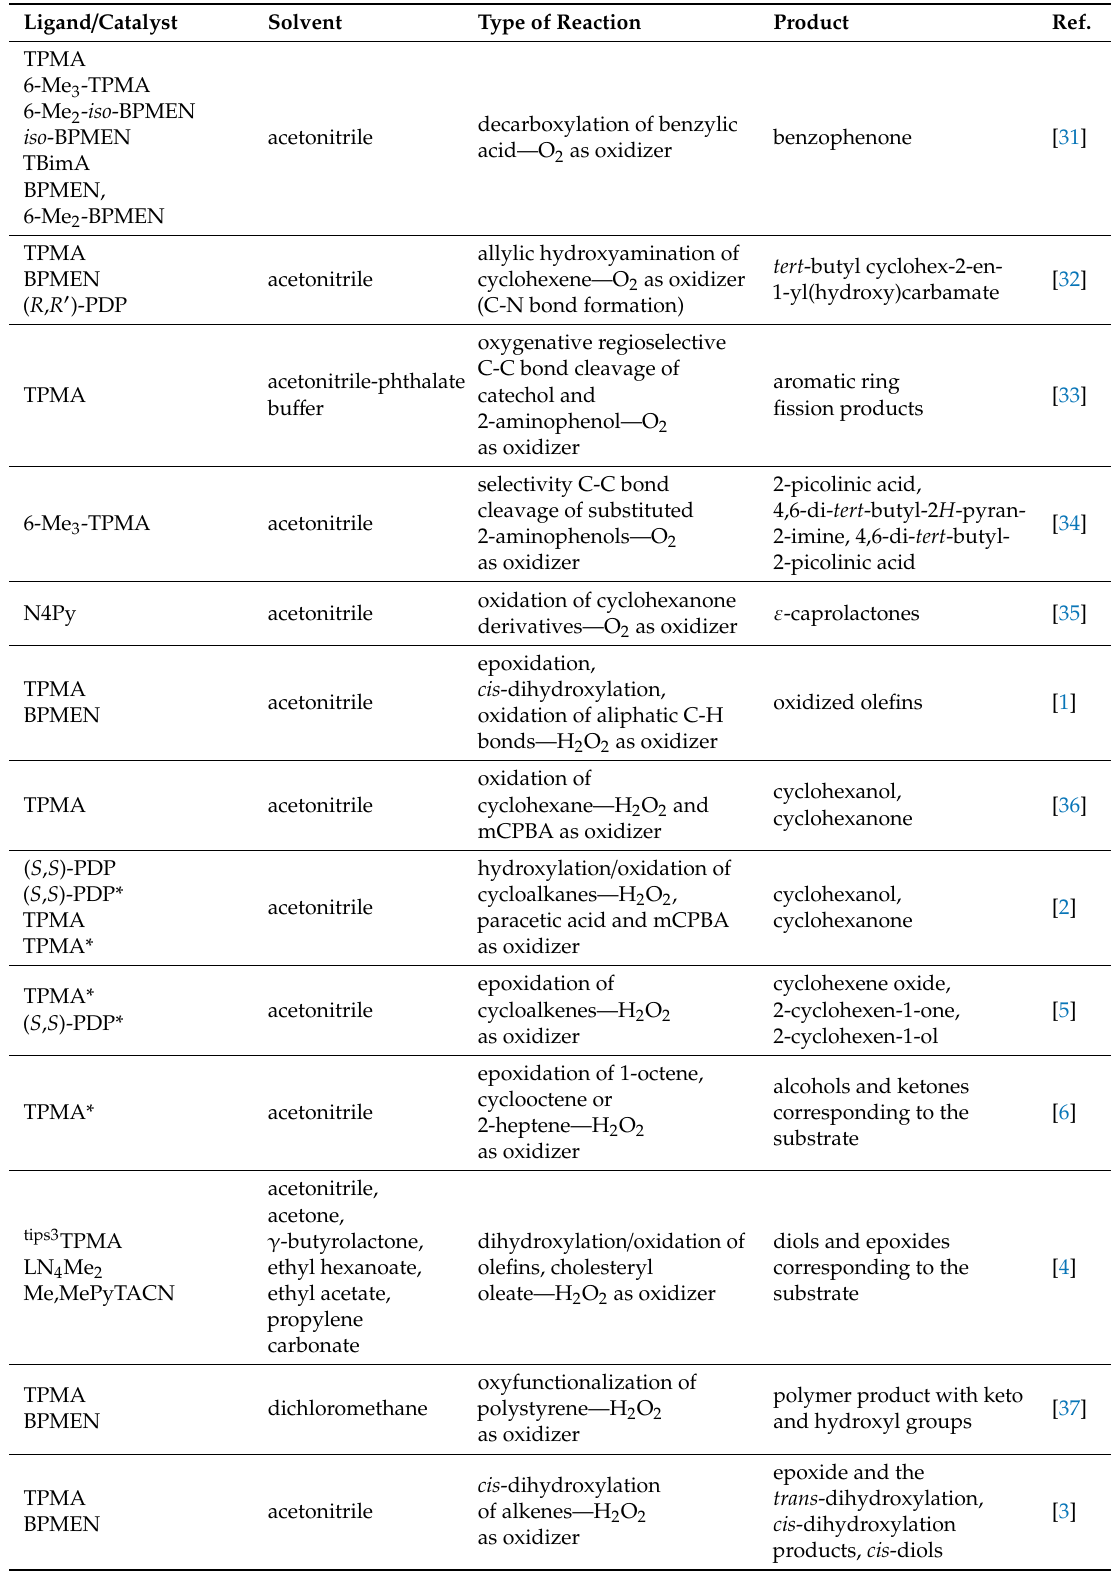
Table 1. Heterogeneous applications of iron complexes with nitrogen-containing ligands. Ligand / Catalyst Solvent